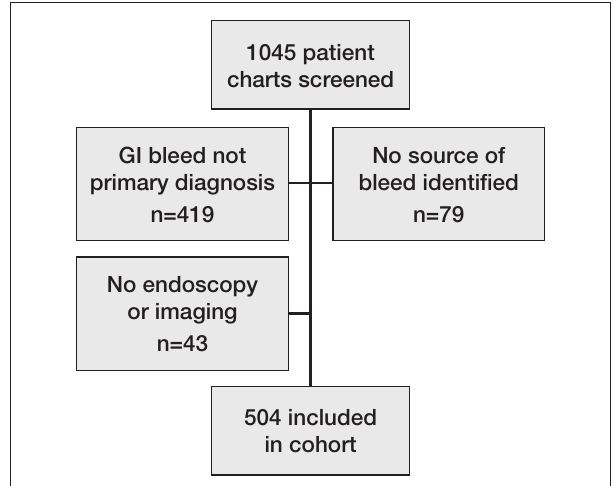
Figure 1) Chart review process. GI Gastrointestinal TABLE 1 demographic characteristics of the study group (n=504) General